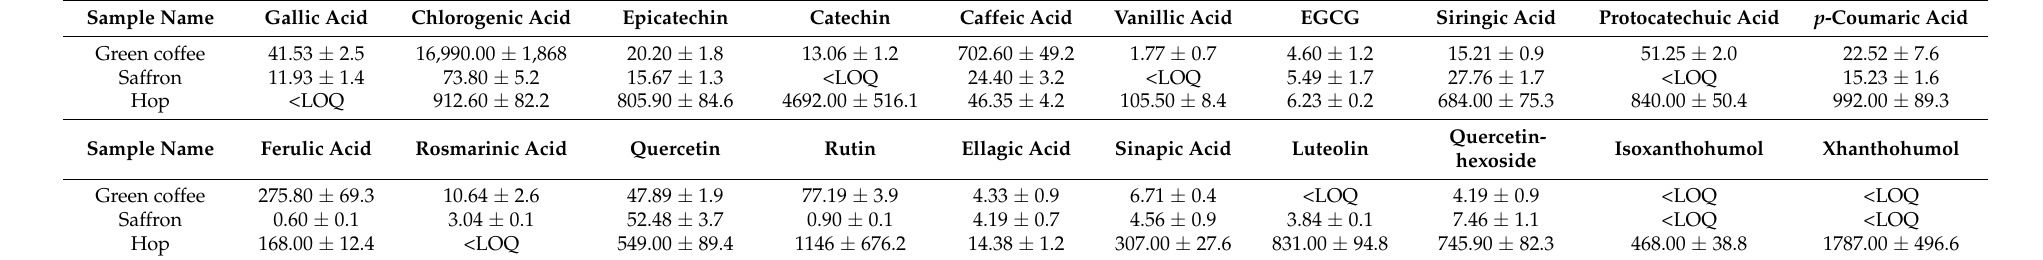
Table 1. PCs identified and quantified with the targeted method in green coffee, saffron and hop samples. Data are reported in µ g/g, and each matrix was analyzed in three biological replicates, which were extracted in three